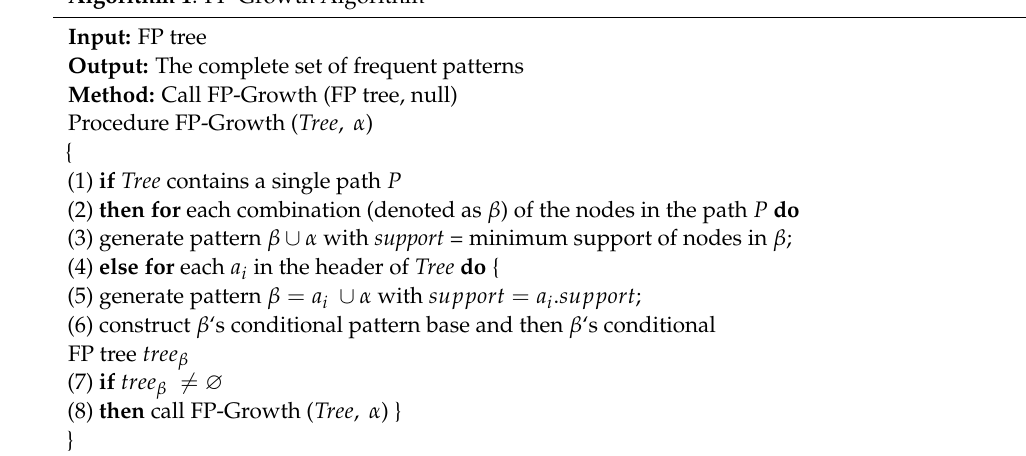
Algorithm 1 . FP-Growth